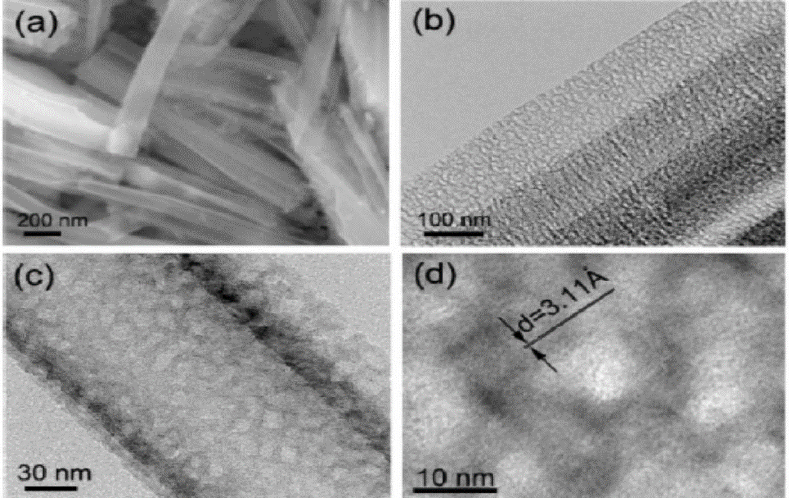
Figure 5. ( a ) SEM and ( b ) TEM images of porous Si nanowires; ( c , d ) High-resolution transmission electron microscopy (HRTEM) image of a nanowire in ( b ), leading to the results in Figure 4. Reproduced with permission from [32]. Copyright Wiley,